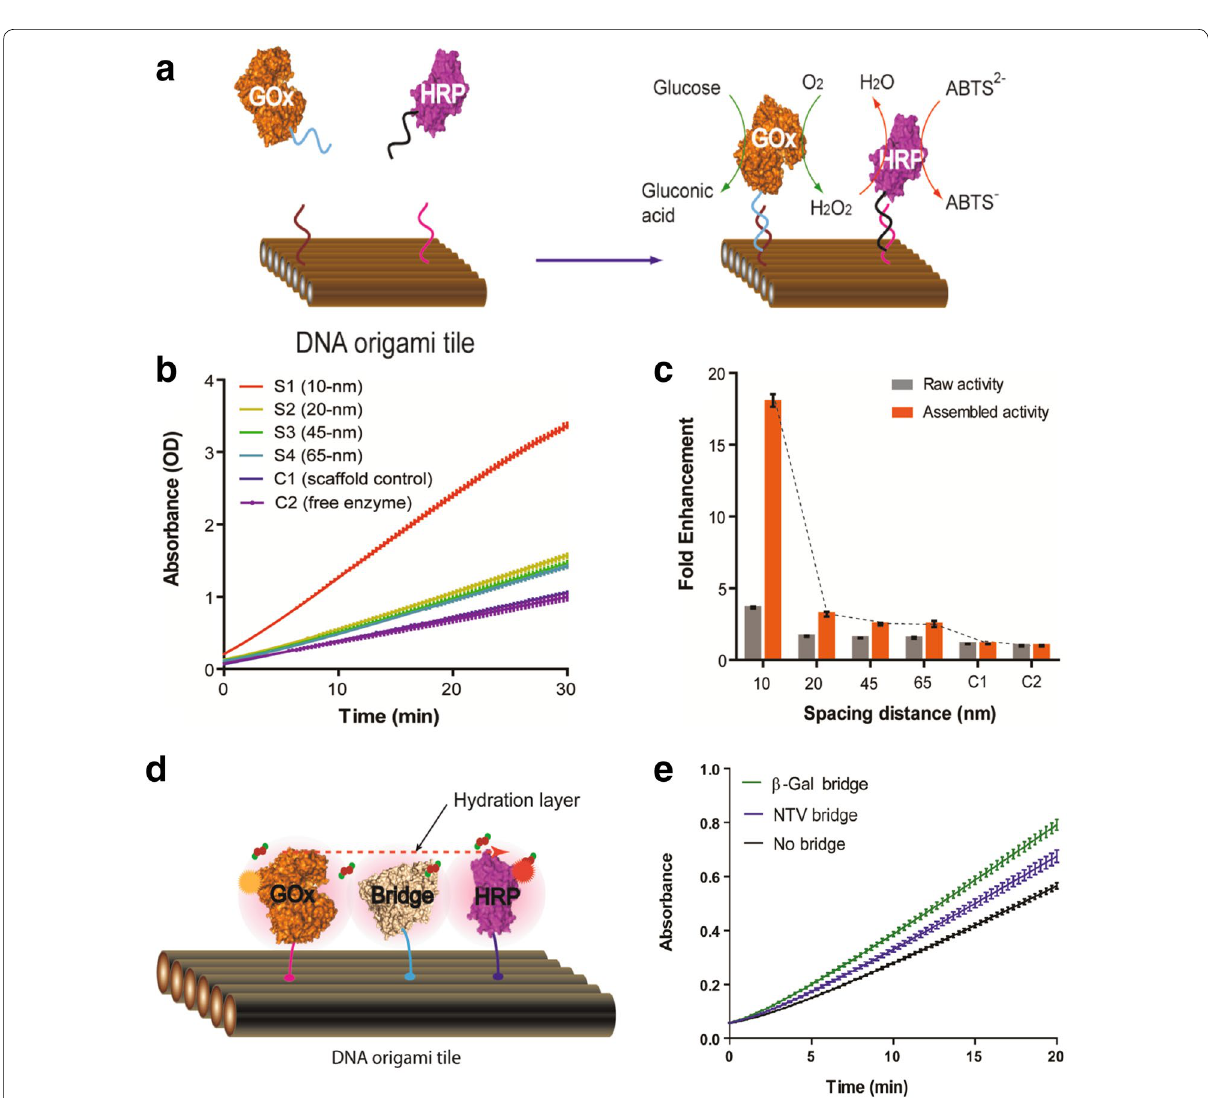
Fig. 13 Schematic illustration of interenzyme substrate diffusion for an enzyme cascade organized on spatially addressable DNA nanostructures. a DNA nanostructure-directed coassembly of GOx and HRP enzymes with control over interenzyme distances and details of the GOx/HRP enzyme cascade. b Spacing distance-dependent effect of assembled GOx/HRP pairs as illustrated by plots of product concentration (Absorbance of ABTS − ) vs time for various nanostructured and free enzyme samples. c Enhancment of the activity of the enzyme pairs on DNA nanostructures compared to free enzyme in solution. d The design of an assembled GOx/HRP pair with a protein bridge used to connect the hydration surfaces of GOx and HRP. e Enhancement in the activity of assembled GOx/HRP pairs with β-Gal and NTV bridges compared to unbridged GOx/HRP pairs (Figure repro- duced with permission from: Ref. [123]. Copyright (2012) American Chemical